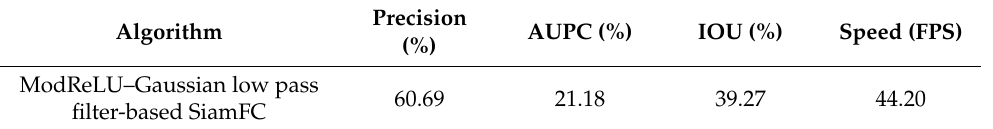
Table 3. Overall results of the proposed ModReLU–Gaussian low pass filter-based